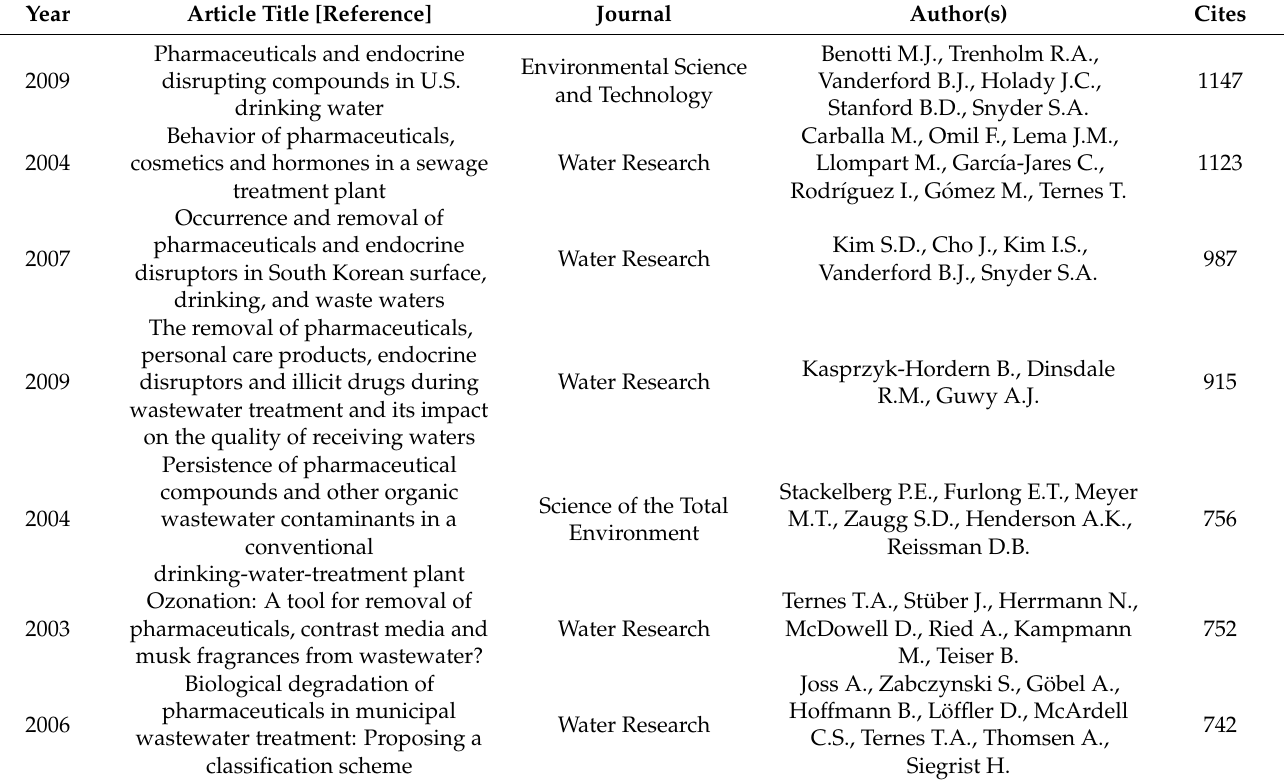
Table 1. Main articles reviewed in relation to the objective of the research